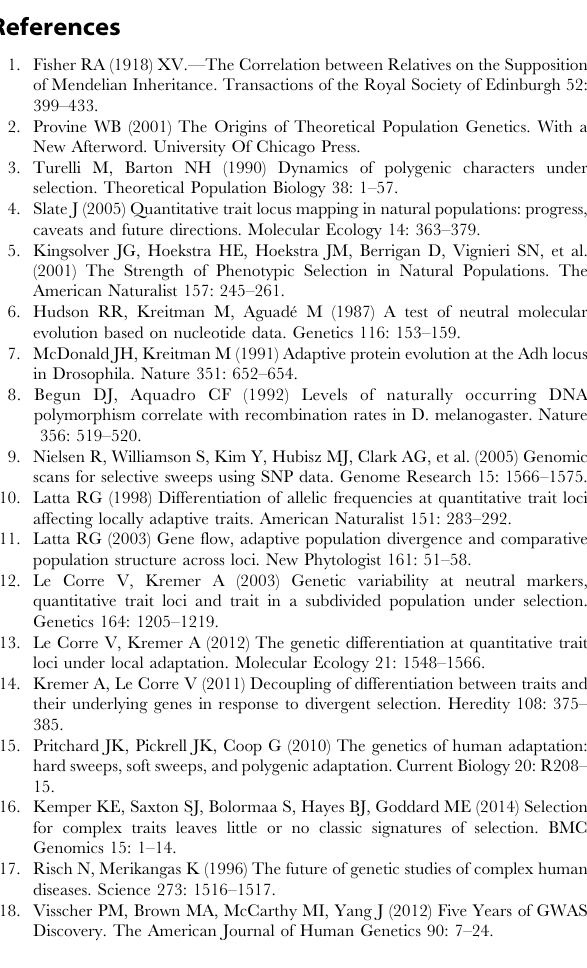
Table S5 Conditional analysis at the regional level for the skin pigmentation dataset. (PDF) Table S6 Conditional analysis at the individual population level for the skin pigmentation dataset. (PDF) Table S7 Condtional analysis at the regional level for the BMI dataset. (PDF) Table S8 Conditional analysis at the individual population level for the BMI dataset. (PDF) Table S9 Conditional analysis at the regional level for the T2D dataset. (PDF) Table S10 Conditional analysis at the individual population level for the T2D dataset. (PDF) Table S11 Conditional analysis at the regional level for the CD dataset. (PDF) Table S12 Conditional analysis at the individual population level for the CD dataset. (PDF)